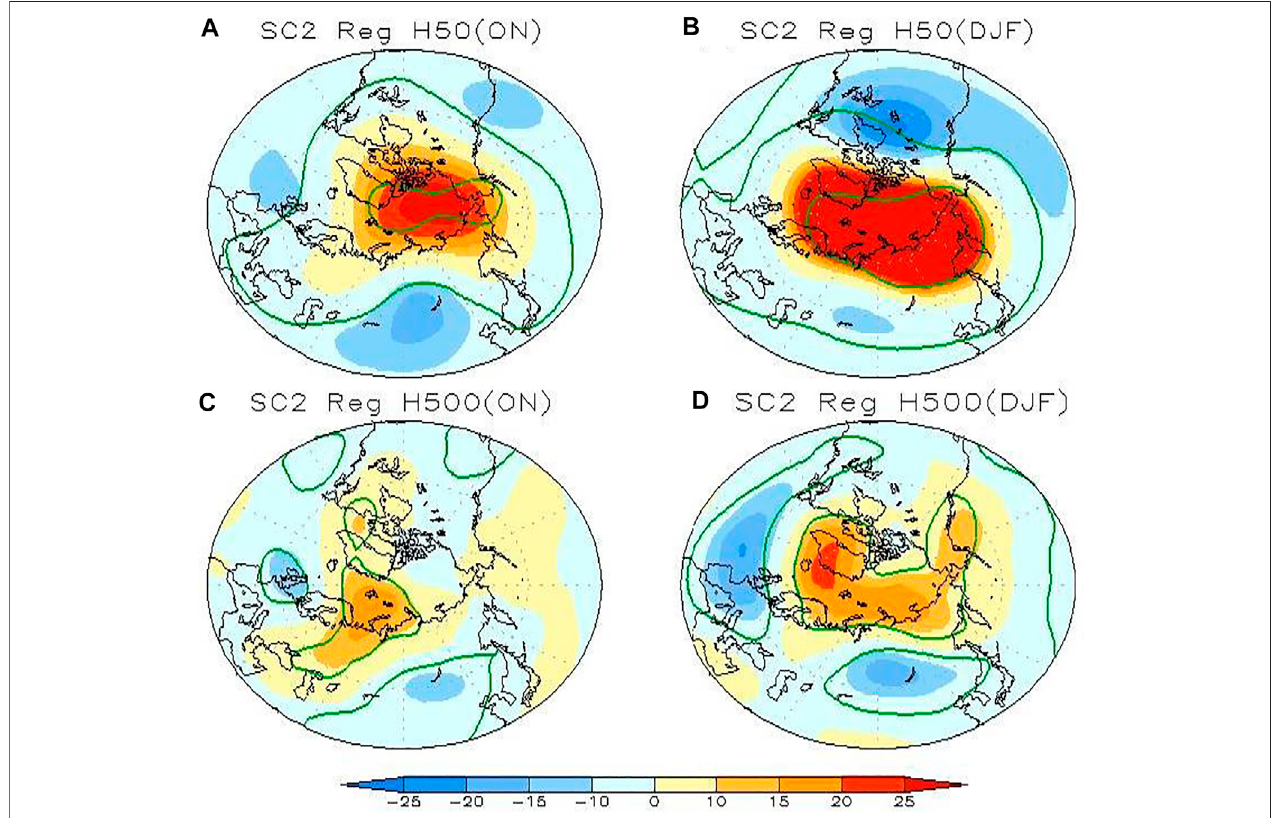
FIGURE 8 | Regressed anomalies of ON (A) , (B) DJF H50 geopotential height (shading, units: m), ON (C) and DJF (D) H500 geopotential height onto expansion coef fi cient time series of snow cover in the second SVD mode. The red line indicates the value signi fi cantly exceeding the 90% con fi dence level.